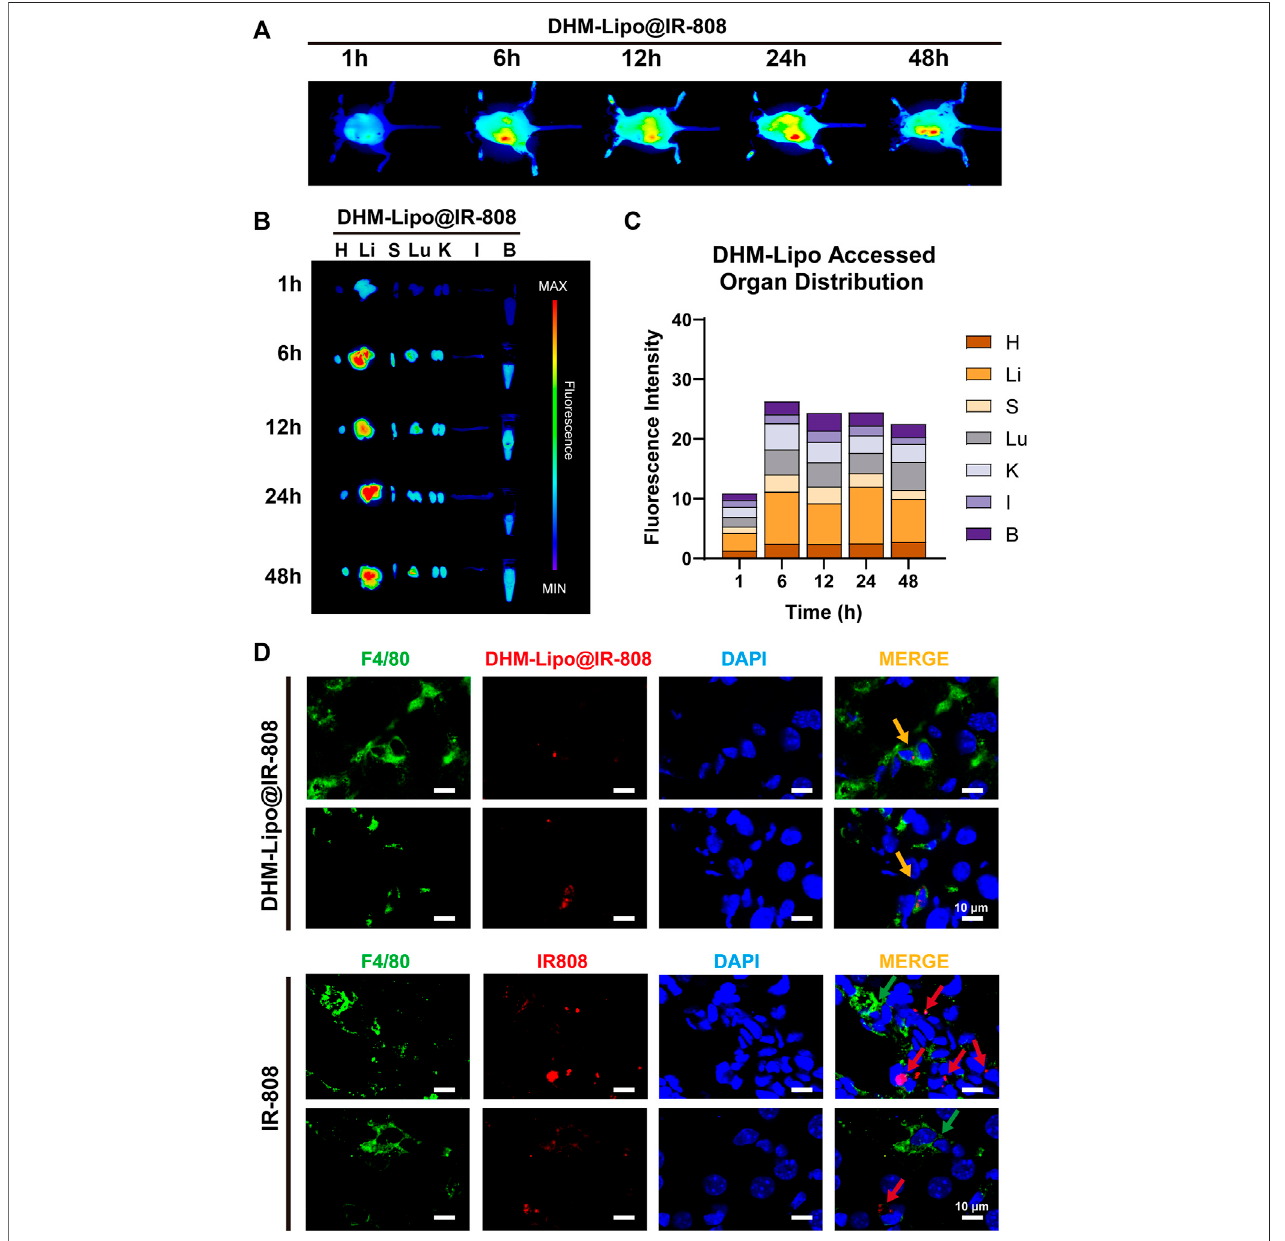
FIGURE 4 | Biodistribution of DHM-Lipo at the organ and cellular levels (A) Preferential accumulation of DHM-Lipo@IR-808 from 1 to 48 h after intraperitoneal injectionwasexaminedby invivo NIR fl uorescenceimaging (B – C) Fluorescencere fl ectanceimaging(FRI) exvivo scansofheart,liver,spleen,lung,kidney,intestine,and blood at 1, 6, 12, 24, and 48 h after intraperitoneal administration of DHM-Lipo@IR-808 at 2 mgkg − 1 . The average radiant ef fi ciency of FRI is shown as a histogram (D) Colocalization of F4/80 with DHM-Lipo@IR-808 or IR-808 in liver tissue as imaged by confocal microscopy. n = 3, Scale bar, 10 μ m.